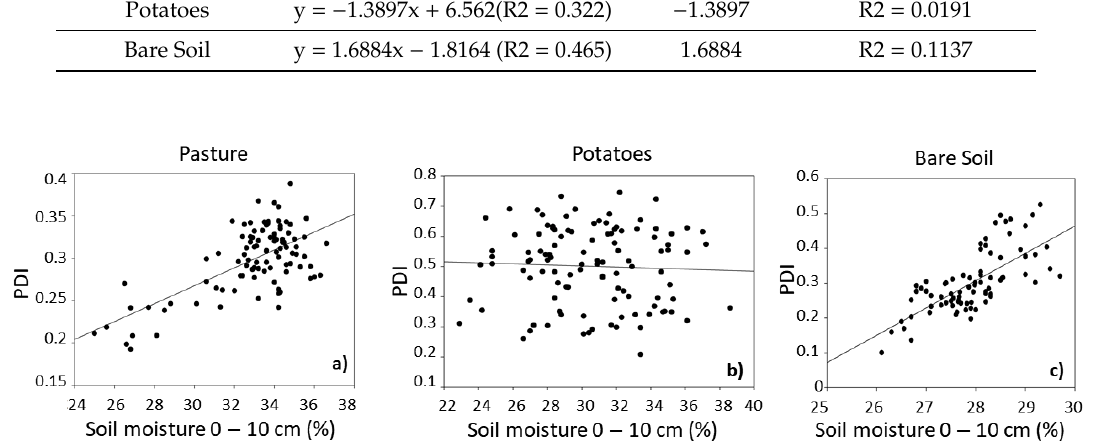
Figure 7. The PDI vs. soil moisture at 0–10 cm depth under different soil uses: ( a ) pasture R² = 0.4392; ( b ) potatoes R² = 0.002; ( c ) bare soil R² = 0.5062) at UAV resolution (4 cm pixel). n = 110. Source: Current research.